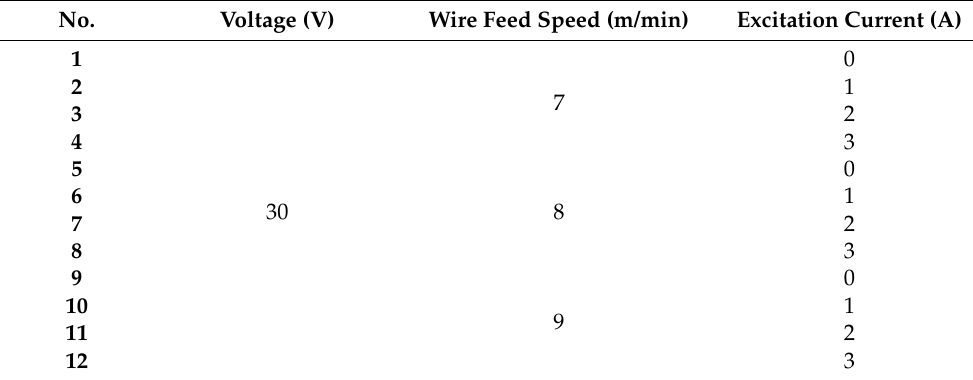
Table 1. Parameters of Ti-6Al-4V alloy during the magnetic field assisted DED-AAM.